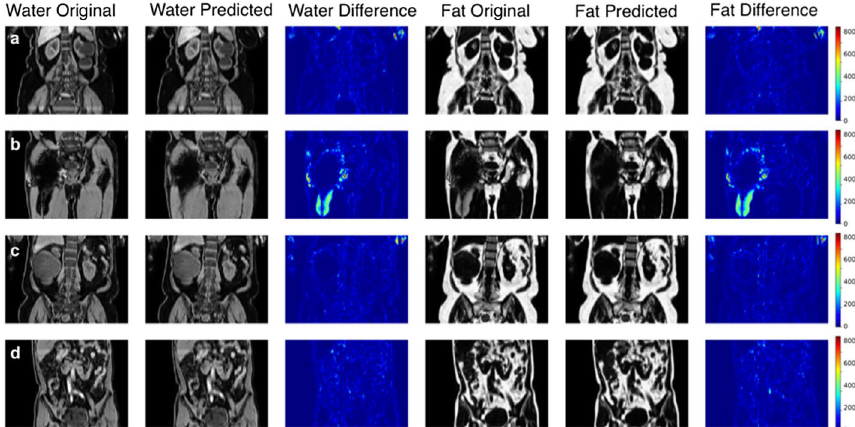
Fig. 5 Model outputs for rare cases of various abnormalities: a kidney cysts, b hip implant and complex partial swap in the muscles, c large liver cyst and d horseshoe kidney. Absolute differences are displayed in